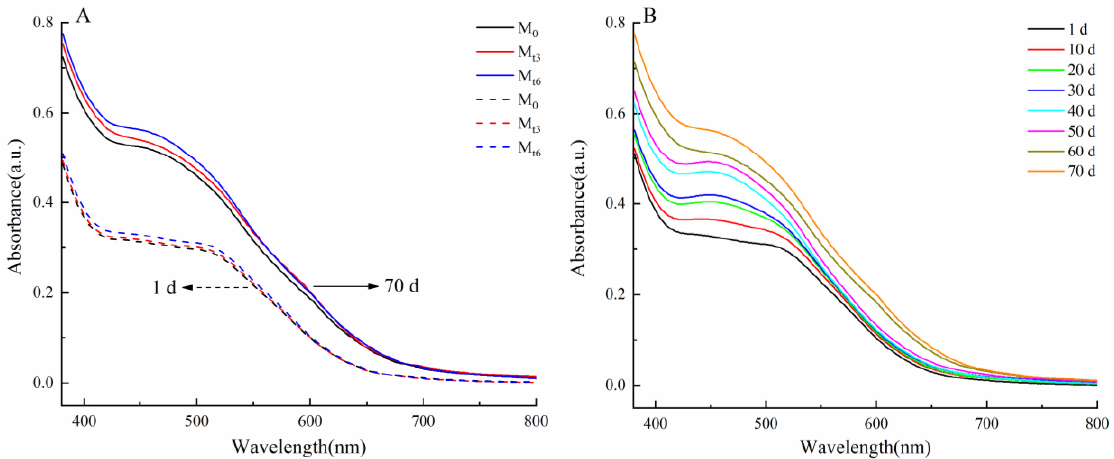
Figure 2. ( A ) Visible spectra of red wine samples on the first day and 70th day of storage. ( B ) Visible spectra of M t6 sample on the first, 10th, 20th, 30th, 40th, 50th, 60th, and 70th days of storage. Table 1. Effect of microwave treatment time and storage time on colour characteristics of red